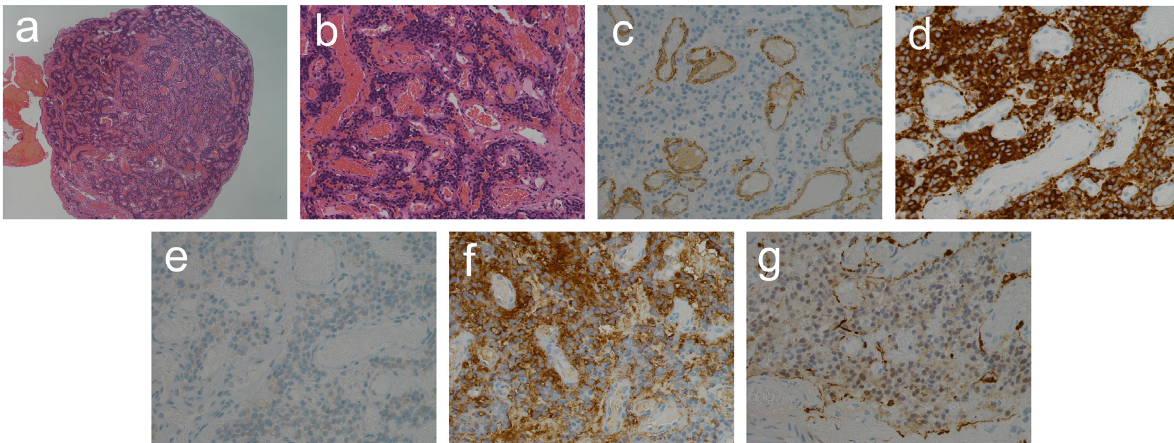
Figure 3: Histopathology. Hematoxylin–eosin staining: (a) reticular vascular-rich round tumor ( × 40) and (b) round tumor cells were aggregated showing ribbon-like (arrow) and island-like (arrow head) formations in vascular spaces (vascular spaces were lined by en- dothelial cells ( × 200)). Immunohistochemical staining ( × 400): (c) α -smooth muscle actin ( α -SMA) was negative, (d) synaptophysin was positive, (e) S-100 protein was positive on sustentacular cells, (f) cytokeratin AE1/AE3 was negative, and (g) neuron-specific enolase (NSE) was